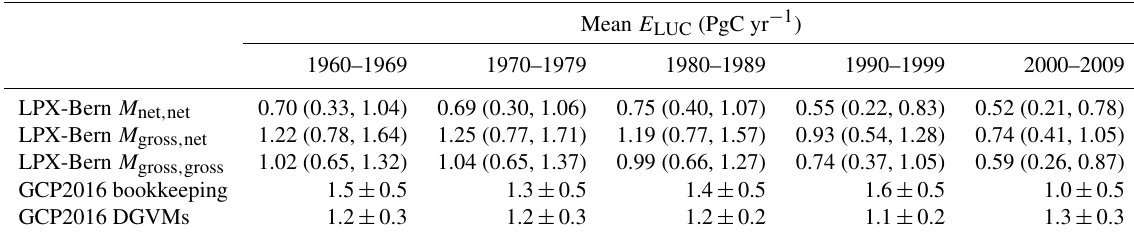
Table 3. Comparison of the skill weighted median emissions due to land-use change in the two constrained LPX parameter ensembles (90% confidence intervals in brackets) to the bookkeeping method and DGVM model ensemble of Le Quéré et al. (2016). The uncertainty in the DGVM multi-model ensemble is given by the standard deviation across model members; for the bookkeeping method a best-value judgement on the uncertainty of ± 0.5PgCyr − 1 is